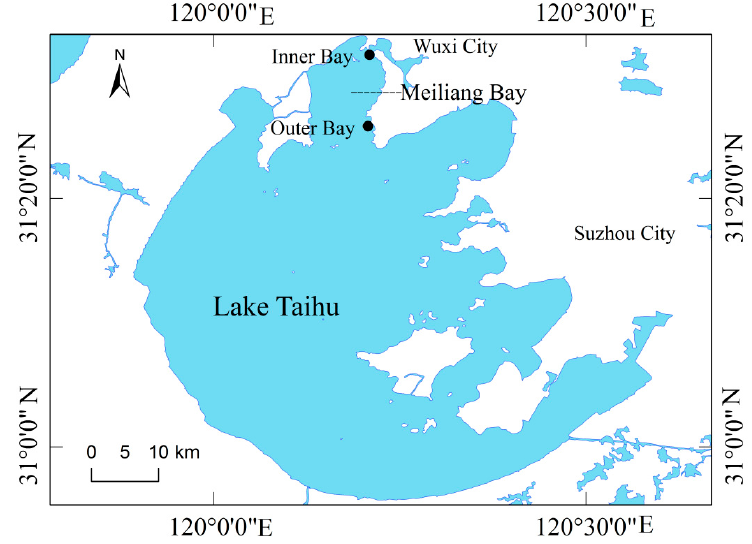
Figure 1. Sampling sites in Taihu Lake, China.